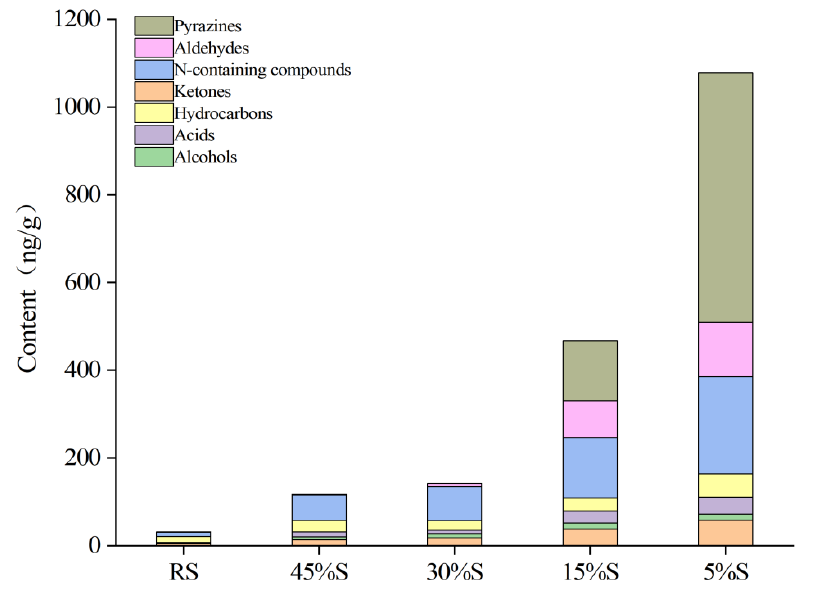
Figure 2. Changes of volatile components in shrimp samples with different moisture contents.